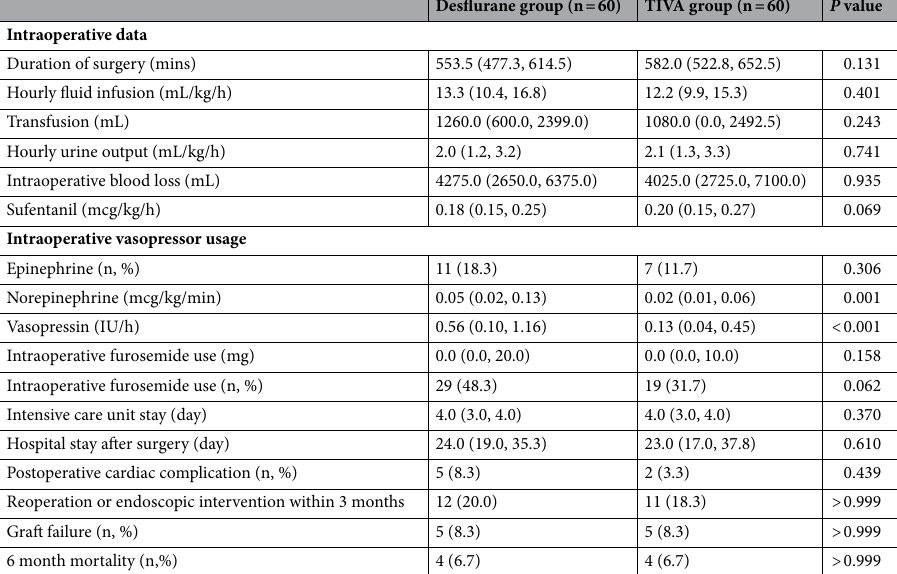
Table 4. Intraoperative data and postoperative outcomes. Data are presented as median (interquartile range) for continuous variables and count (percentage) for categorical variables. TIVA, total intravenous